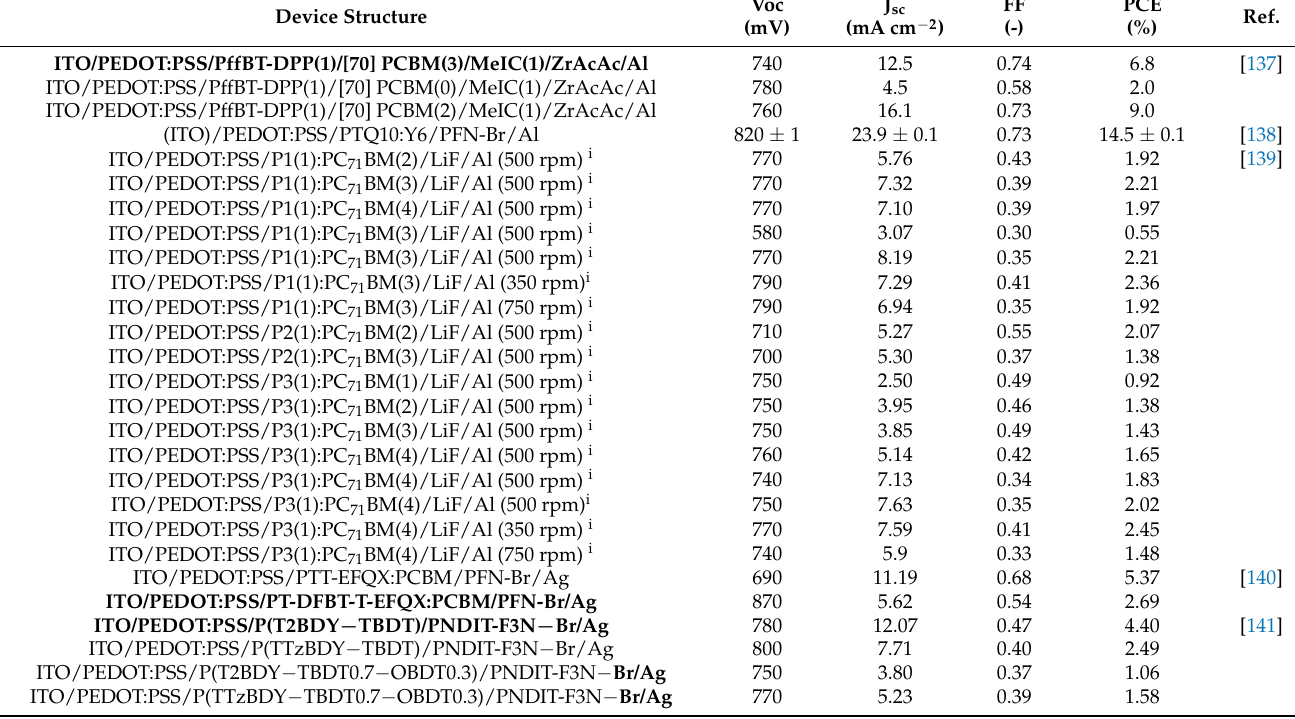
Table 7. Photovoltaic parameters of solar cells contain narrow bandgap polymer donors. Device